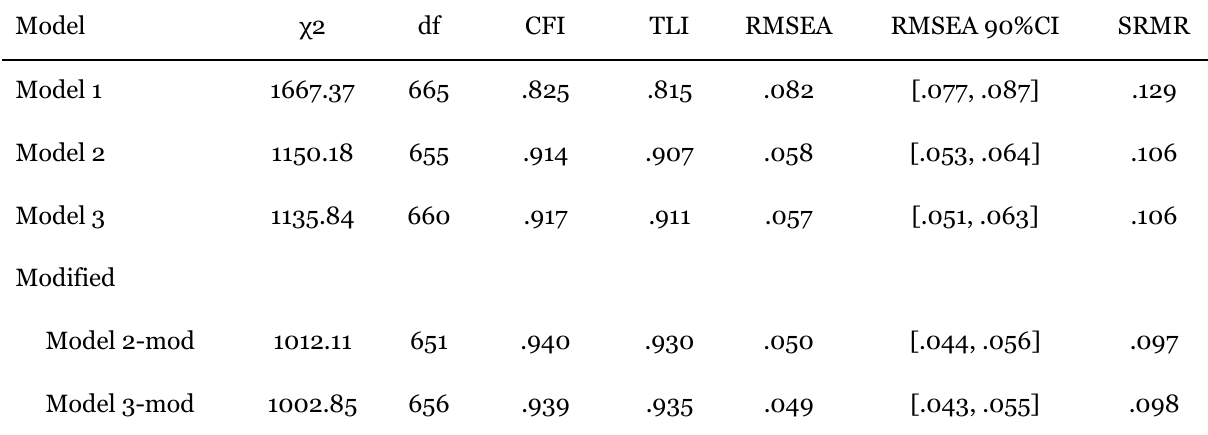
Goodness-of-Fit